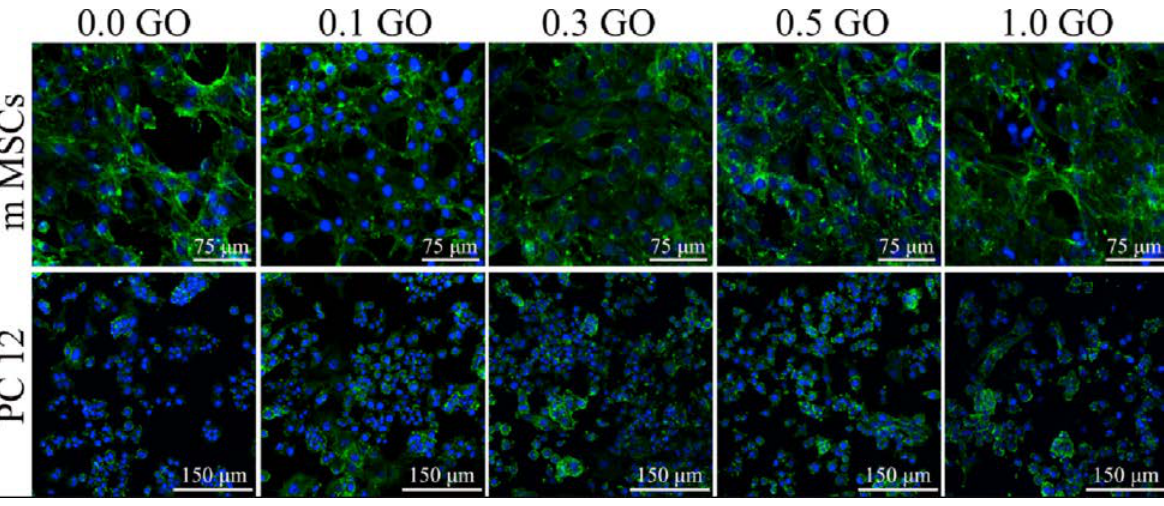
Figure 10. Images of mMSC and PC12-L cell proliferation on PCL scaffolds modified by GO, after 3 days of cell culture with different concentrations of GO (wt%). Reprinted from [100] with permission from Elsevier.